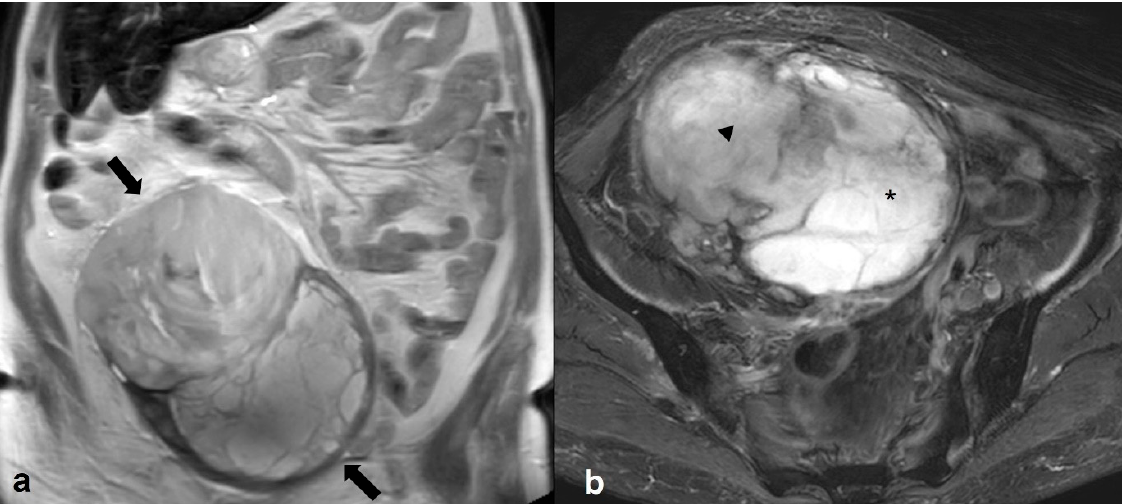
Figure 23. Malignant peripheral nerve sheath tumor (MPNST). Coronal T2 weighted image ( a ) shows a large, encapsulated pelvic mass extending in the upper abdomen (arrows). On the axial T2 weighted FS image ( b ), the mass consists of a high signal intensity, lobulated component on the left (asterisk) and a lower signal intensity component on the right (arrowhead).